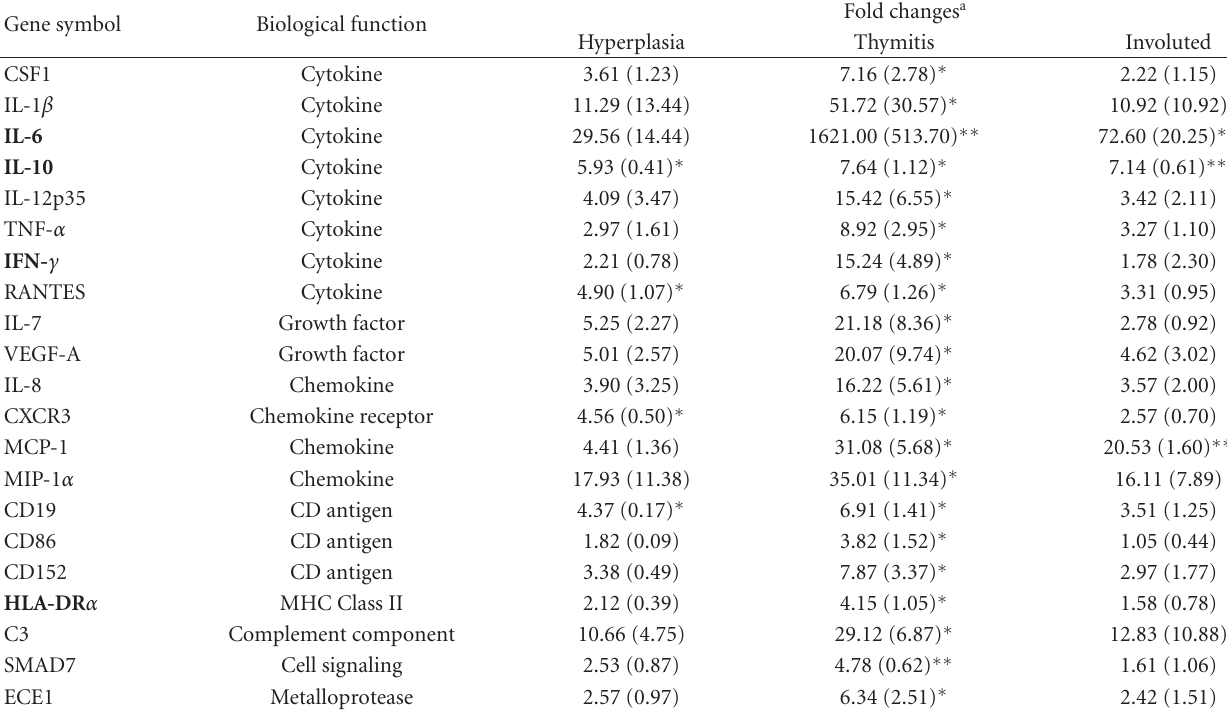
Table 2: Upregulated genes in follicular hyperplasia, thymitis, and involuted thymus versus normal thymus identified by TaqMan low- density arrays